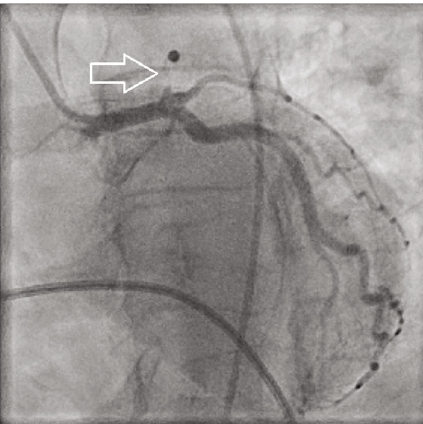
Figure 1: Angiography of the left coronary arteries revealing total occlusion of proximal LAD (arrow).